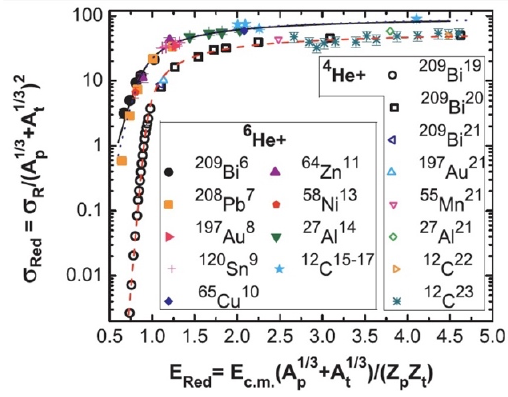
Fig. 3. Reaction cross sections for 6 He and 4 He at several collision energies and targets